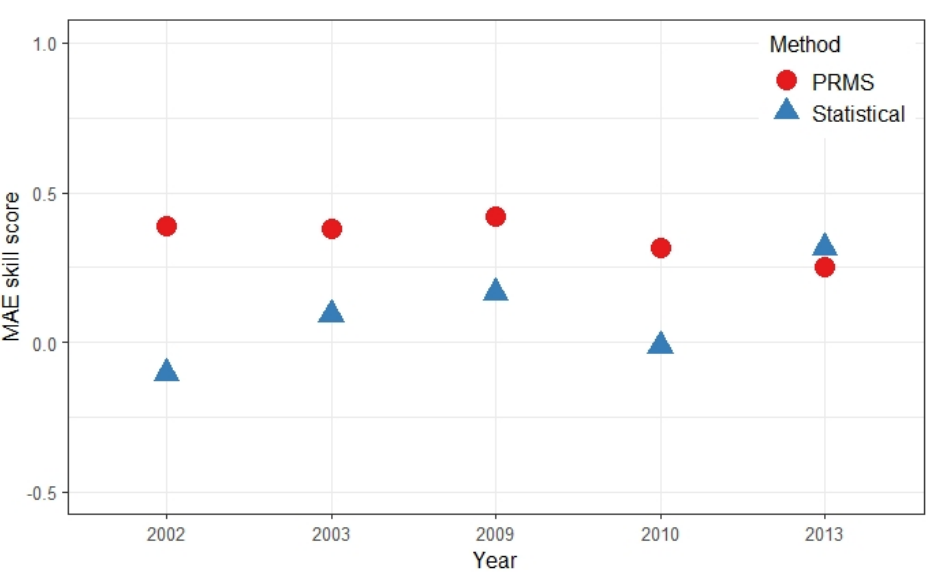
Figure 8. The m onthly increase in energy value (“enhanced forecasting method”–“statistical”) of the selected years under two price scenarios.